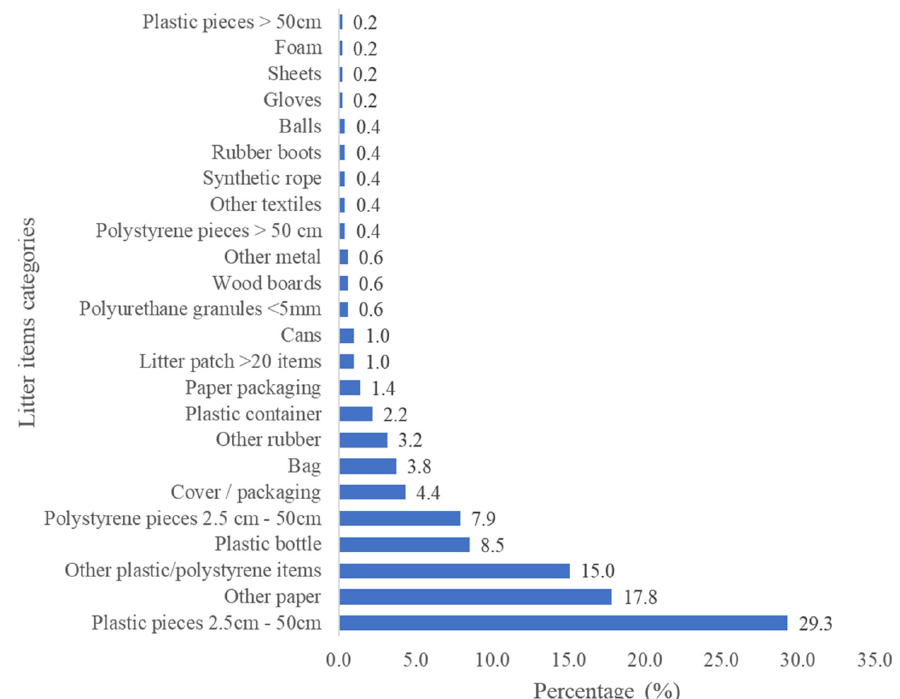
Figure 5. Percentage of recorded litter item categories at the Sochi River.